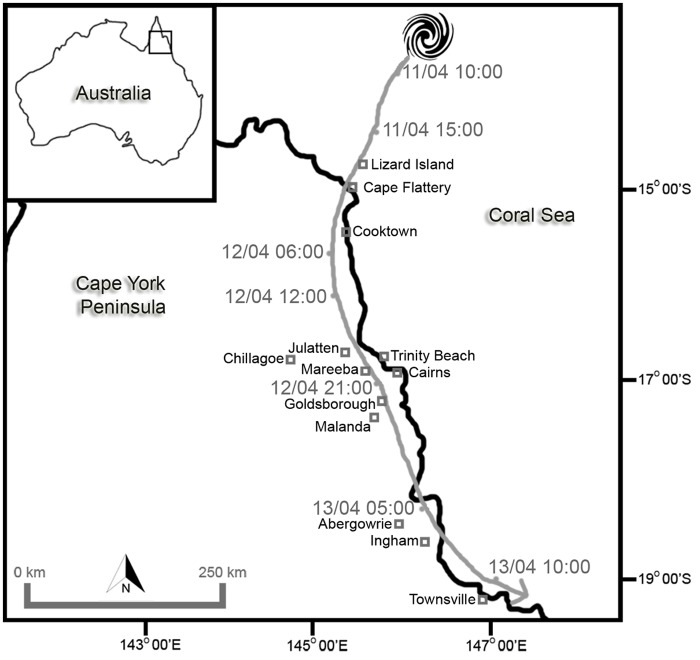
Sampling locations and track of TC Ita April 11 to 13, 2014 [14, 15].